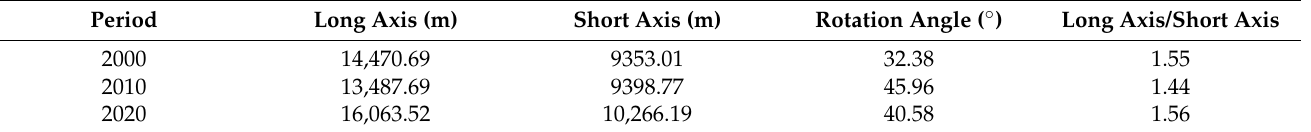
Table 4. Parameters of SDE from 2000 to 2020.